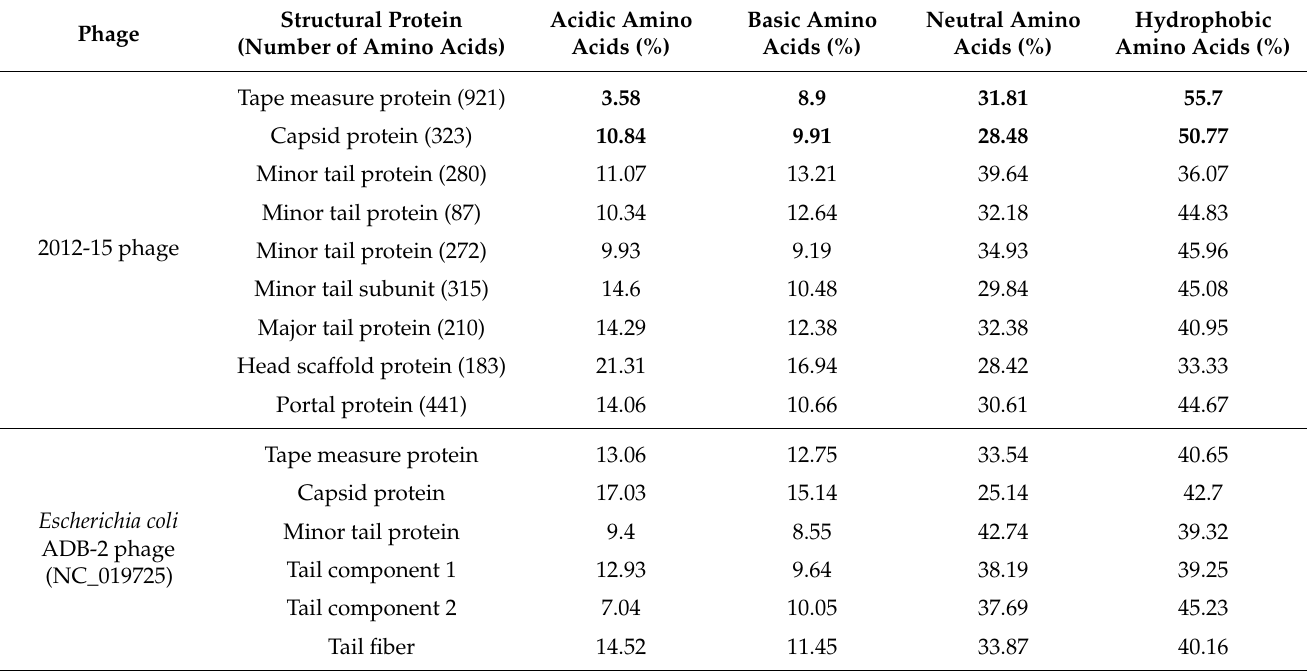
Table 2. Hydrophobicity of major structural proteins of 2012-15 and ADB-2 bacteriophages. Bold numbers indicate proteins with more than 50% hydrophobic amino acid composition and which may be insoluble or partially soluble in aqueous